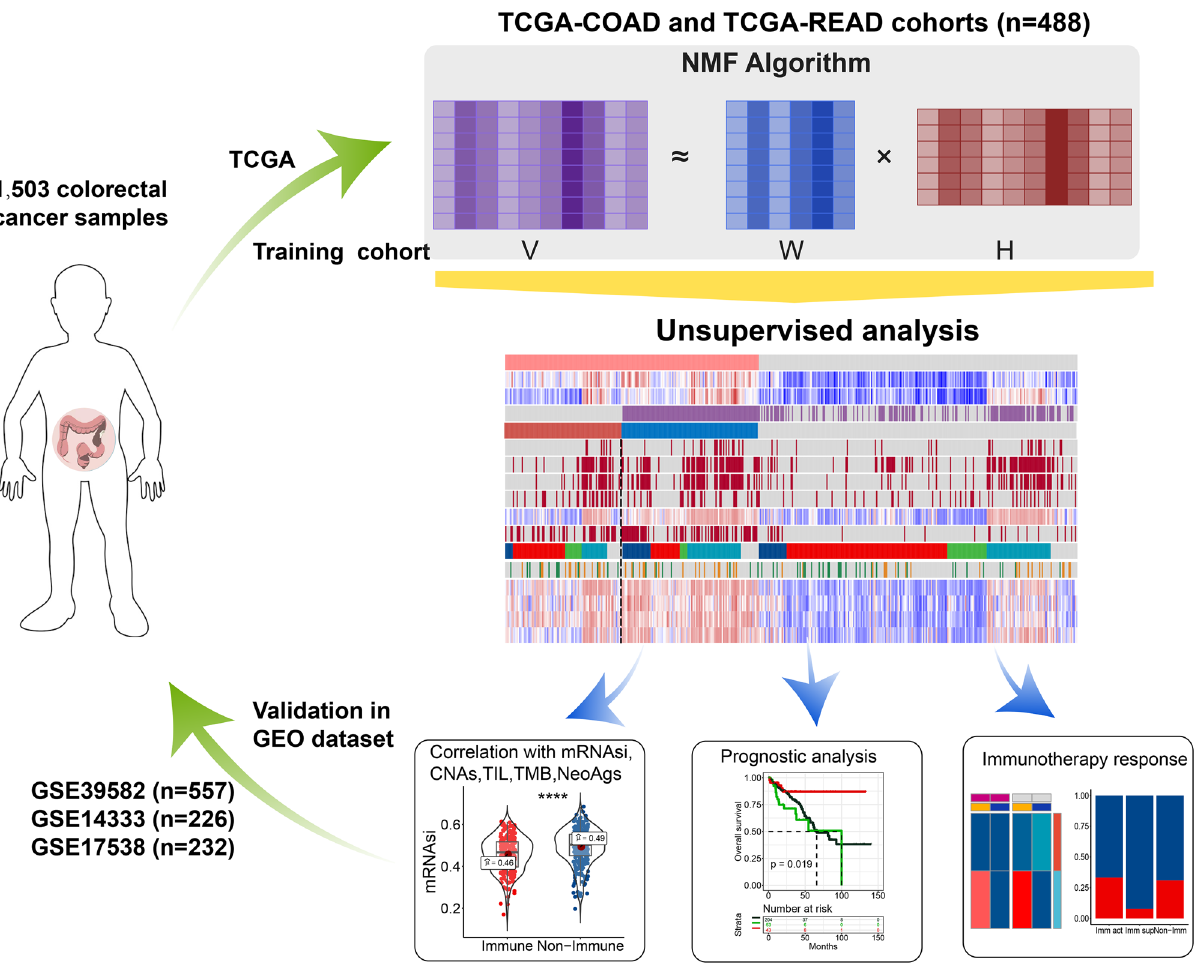
Figure 1. Flow chart of the analyses conducted in this